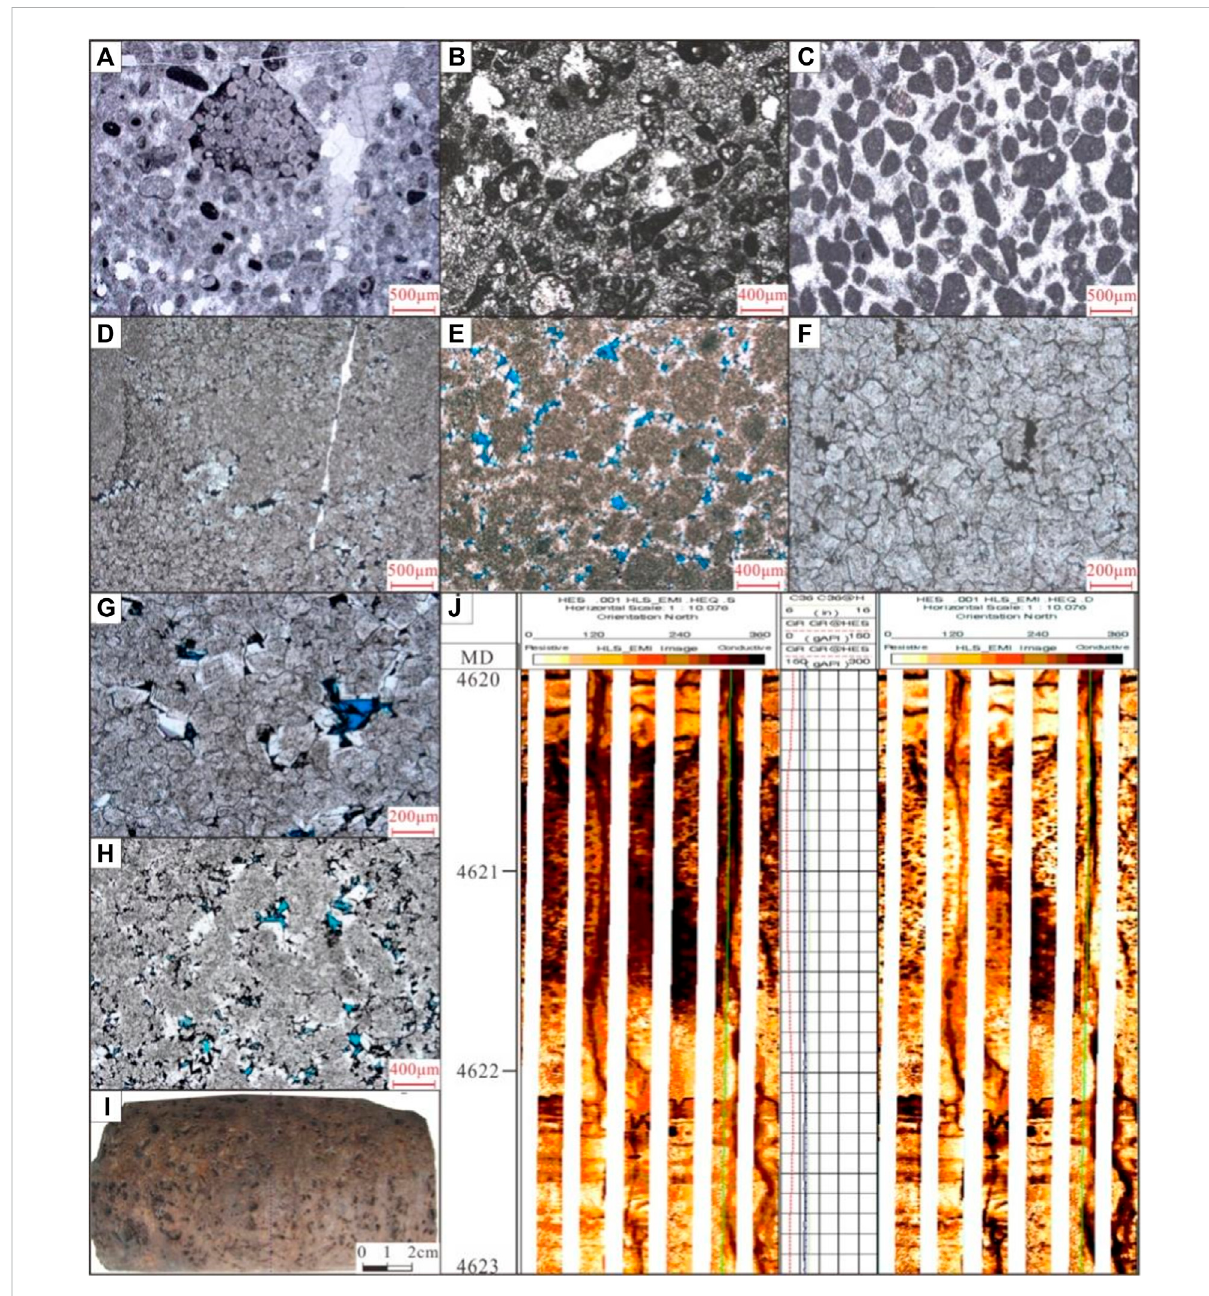
FIGURE 3 Reservoir space types of Xixiangchi Formation in the Southern Sichuan Basin. (A) Well WH1, Xixiangchi Formation, 2,209 m, medium granular dolomite; (B) Well N2, Xixiangchi Formation, 2,100 m, medium to coarse granular dolomite; (C) Well WH1, Xixiangchi Formation, 2,232 m, medium granular dolomite; (D) Well DS1, Xixiangchi Formation, 5,332.3 m, fi ne crystalline dolomite, developed intermediate dissolved pores; (E) Well H12, Xixiangchi Formation, 4,848.6 m, fi ne crystalline dolomite with residual grain texture, intercrystalline dissolved pores developed; (F) Well L1, Xixiangchi Formation, 2,105 m, coarse crystalline dolomite, intercrystalline dissolved pores developed and fi lled with bitumen; (G) Well LL1, Xixiangchi Formation, 2,246.50 m, coarse crystalline dolomite, intercrystalline dissolved pores developed and fi lled with bitumen; (H) Well LG1, Xixiangchi Formation, 4,624.38 m, fi ne crystalline dolomite with residual grain texture, intercrystalline dissolved pores developed and fi lled with bitumen; (I) Well WS1, Xixiangchi Formation, 2,254 m, granular dolomite, with intergranular dissolved pores and vugs; (J) Well H12, Xixiangchi Formation, 4,620 – 4,623 m image logging feature map, developed pinhole dissolution holes and vertical